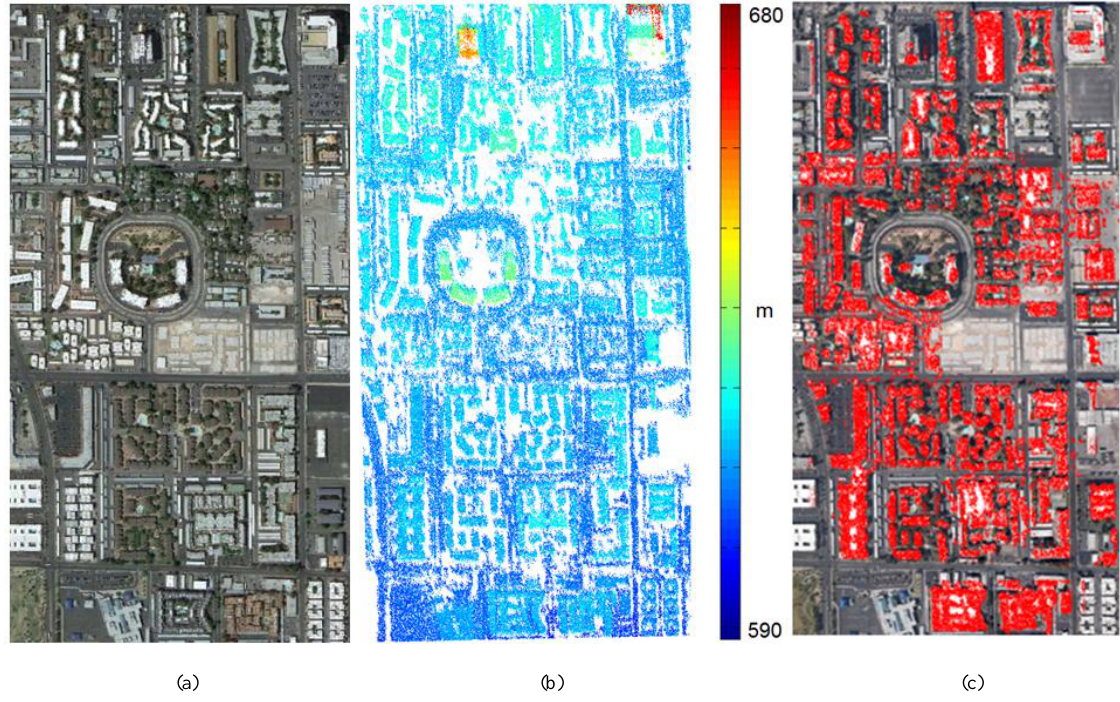
Figure 6: Roof points extraction results: (a) Optical image of the Testsite 1 containing relatively smaller buildings in densely populated regions in the city of Las Vegas © Google Earth; (b) TomoSAR points in UTM coordinates of the corresponding test image. The height of TomoSAR points is color-coded [unit: meter]; (c) Extracted roof points overlaid onto the optical